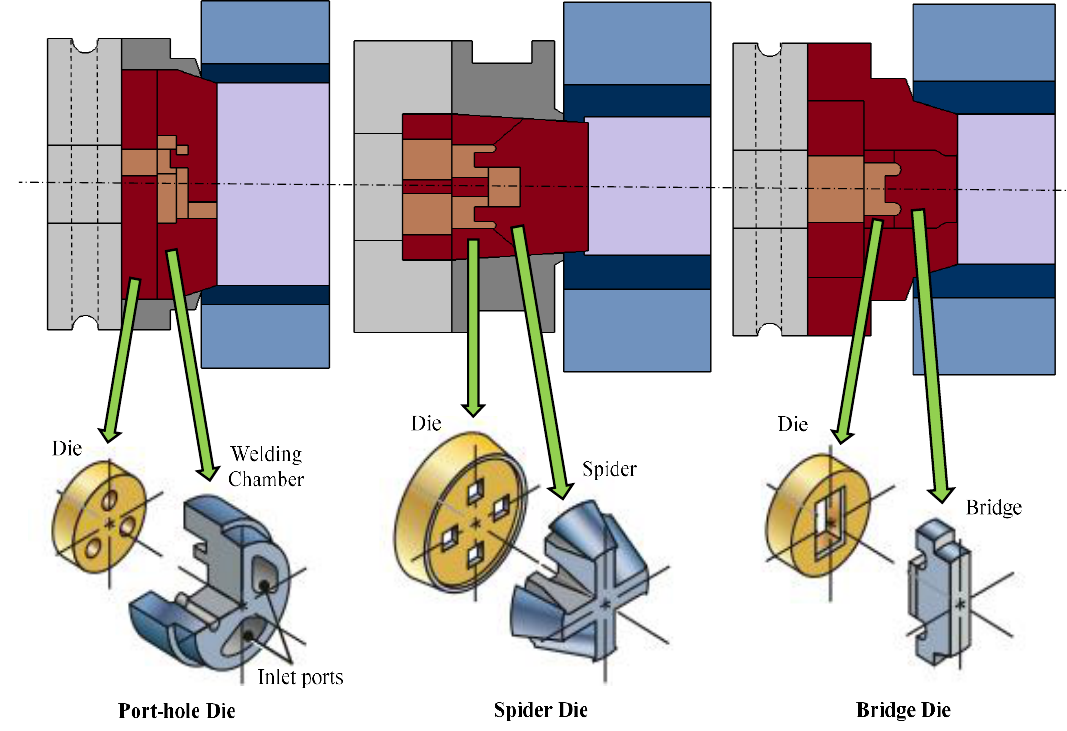
Figure 4. Three major hollow extrusion setups: port-hole die, spider die, and bridge die.